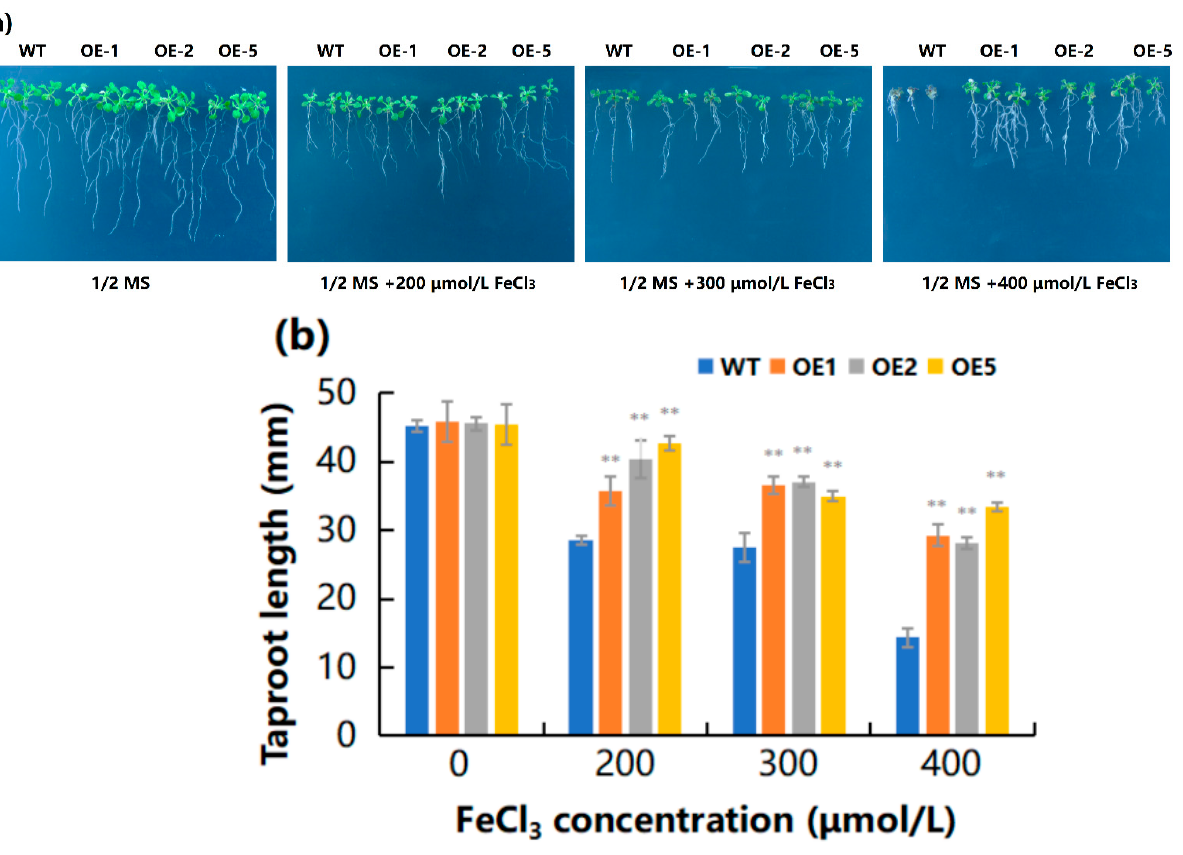
Figure 7. Functional validation of MeGLYI-13 for iron stress resistance using the overexpression in Arabidopsis . ( a ) Phenotypes of the transgenic and wild-type Arabidopsis under different concentrations of FeCl 3 . ( b ) Taproot length statistics of the transgenic and wide-type Arabidopsis under different Fe concentration treatments. Values are means and standard deviations (n = 3). ** indicates the significant difference p ≤ 0.01.